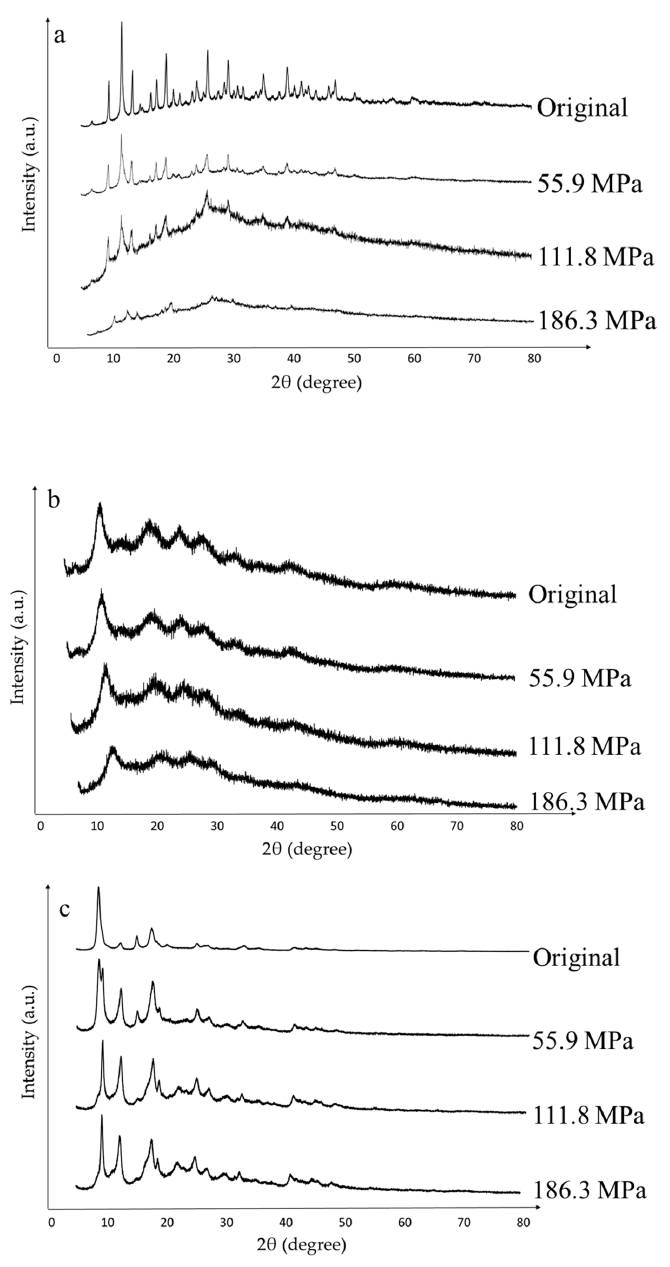
Figure 5. Powder X-ray diffraction (PXRD) patterns of the three materials at different applied pressures ( a : Basolite C300, b : Basolite F300 and c : Basolite A100). Applied pressures are ordered from top to bottom in increasing order (0, 55.9, 111.8 and 186.3 MPa). The pristine Basolite C300 powder X-ray diffraction (PXRD) pattern shows the typical peaks reported for this material at 2 θ = 6.7°, 9.5°, 11.65°, 13.5°, 19.3° and 26°, in addition to three little peaks at 35.5°, 38.7° and 36.43°, which indicate some CuO and Cu 2 O impurities [45,46]. After pressure is applied, the intensity of the peaks decreases progressively, indicative of crystallinity loss (Table 2). As its PXRD pattern is practically coincident with HKUST-1, a face-centered cubic structure is